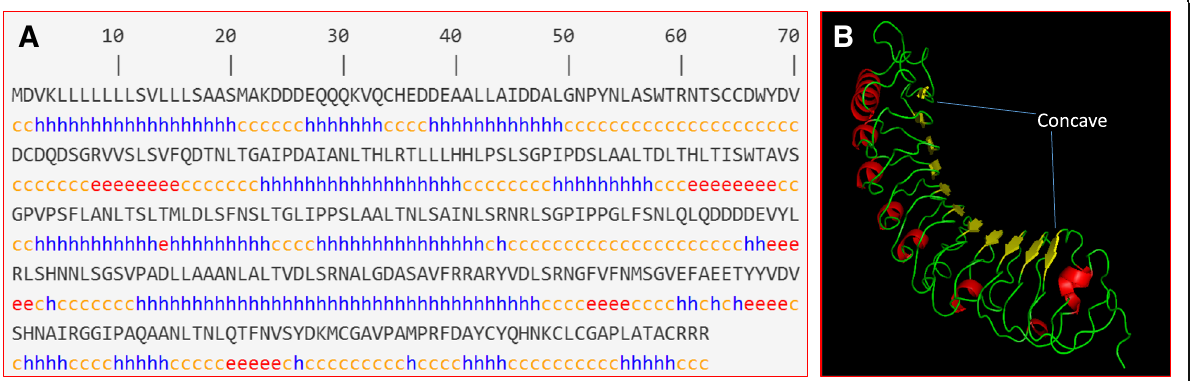
Fig. 1 The secondary and tertiary structure of deduced OsPGIP2. a , Secondary structure of OsPGIP2. Lowercase c, h and e represent random coils, α -helices and extended strands, respectively. b , Tertiary structure of OsPGIP2 predicted by homology modeling. α -helices are shown in red, and β -strands are indicated in